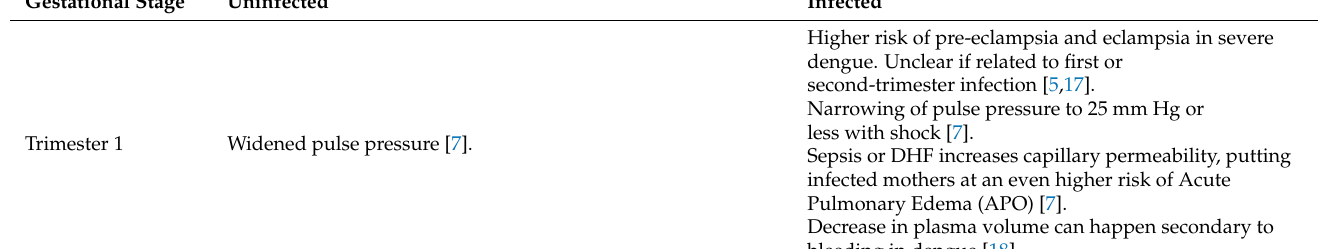
Refer to above for general altered physiology for dengue in pregnant